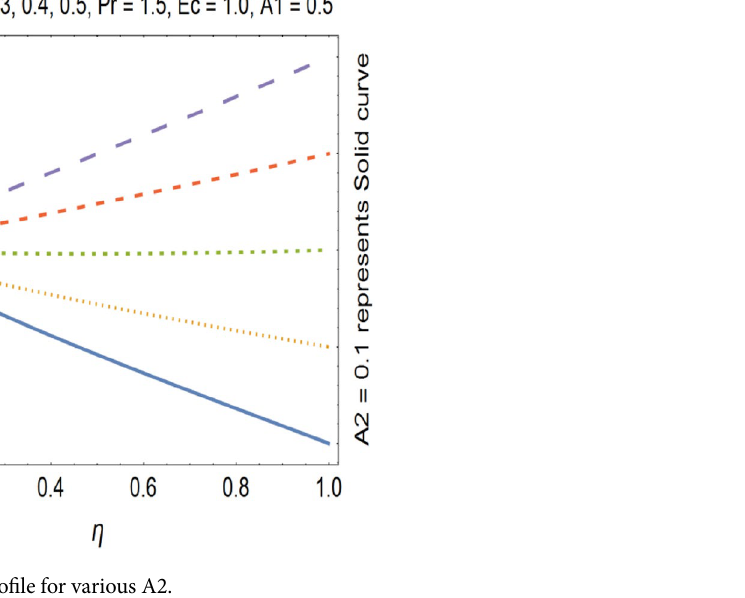
Figure 10. Velocity profile for various